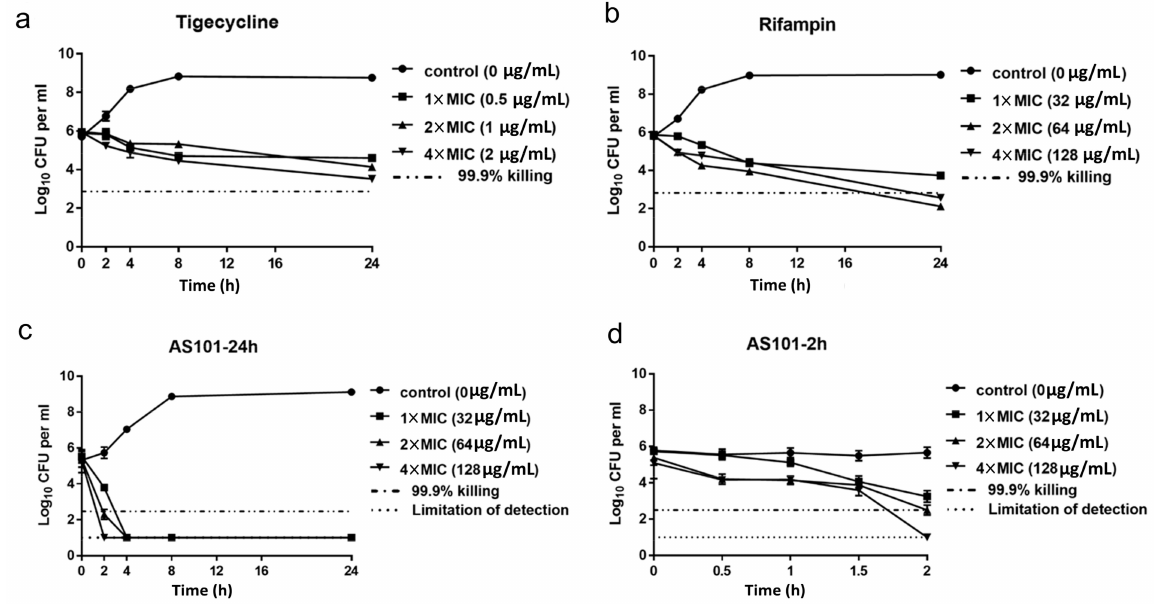
Figure 1. Time-kill kinetic assays of AS101 against carbapenem-resistant K. pneumoniae ATCC BAA-1705. Following treatment with 1 × MIC (filled squares), 2 × MIC (filled triangles), or 4 × MIC (filled inverted triangles) (Table S1) of ( a ) tigecycline, ( b ) rifampin, ( c ) AS101, or untreated (control, filled circle), carbapenem-resistant K. pneumoniae ATCC BAA-1705 viability was measured for 2, 4, 8 and 24 h. ( d ) Due to its effective antibacterial activity, short-term kinetic assays were performed for AS101. Points, means; bars, standard deviations for triplicate experiments. Dotted-dashed lines indicate a 99.9% reduction of beginning inoculum. Dotted lines indicate detection limits. CFU, colony-forming unit. See also Figure S4 for results of